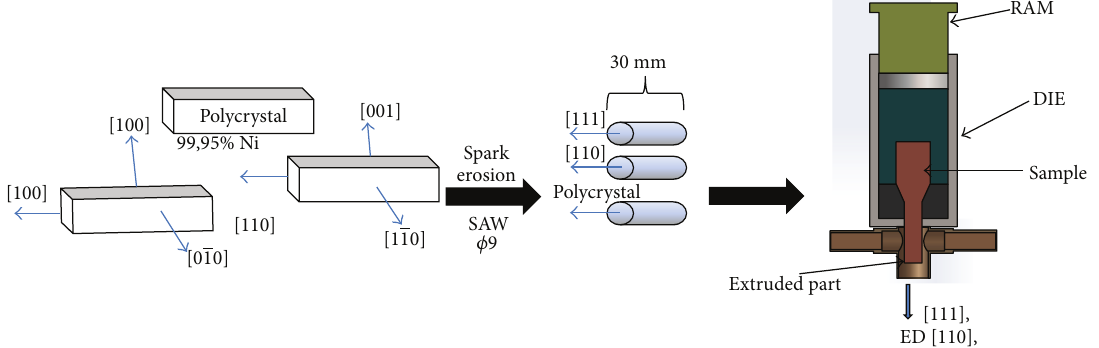
Figure 1: Schematic representation of the experiment process.